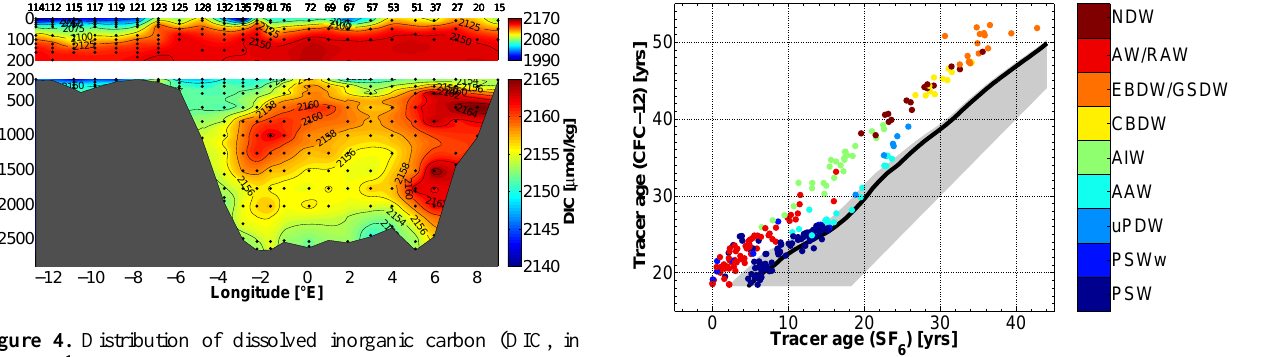
Figure 5. Validity area of the IG-TTD, defined by the tracer couple CFC-12 and SF 6 (grey shaded area). The black line indicates the IG- TTD-based tracer age relationship using the unity ratio of (cid:49)/(cid:48) = 1 . 0. The field data are colored by the type of water mass. The lower set (blue dots) describes surface and intermediate water of Arctic origin whereas the upper set includes water of Atlantic origin and deep water